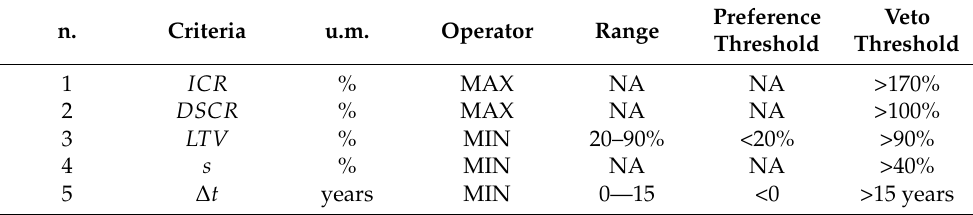
Table 5. Range and thresholds of the criteria.